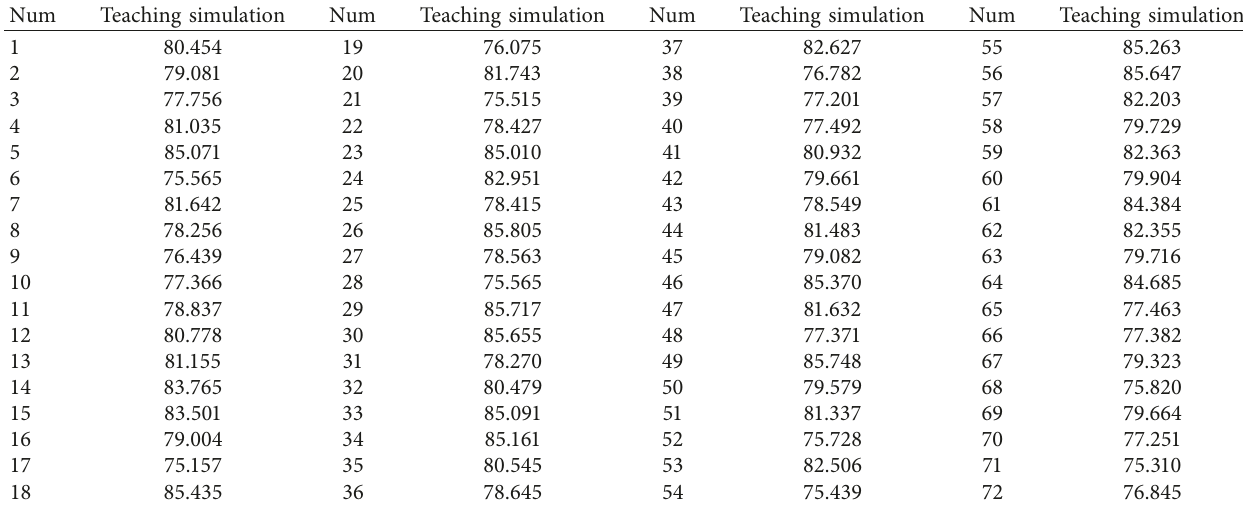
Table 1: The effect of virtual simulation